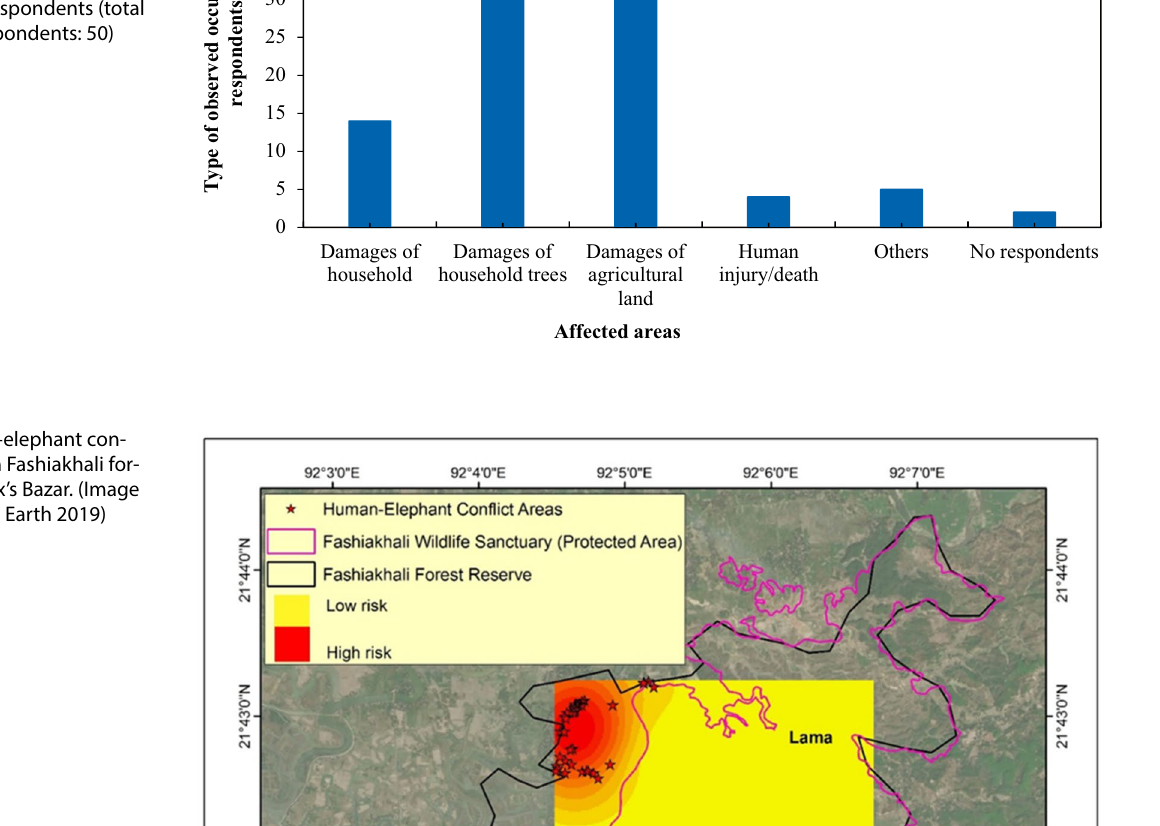
Fig. 6 Type of affected areas by elephant observed by respondents (total number of respondents: 50)